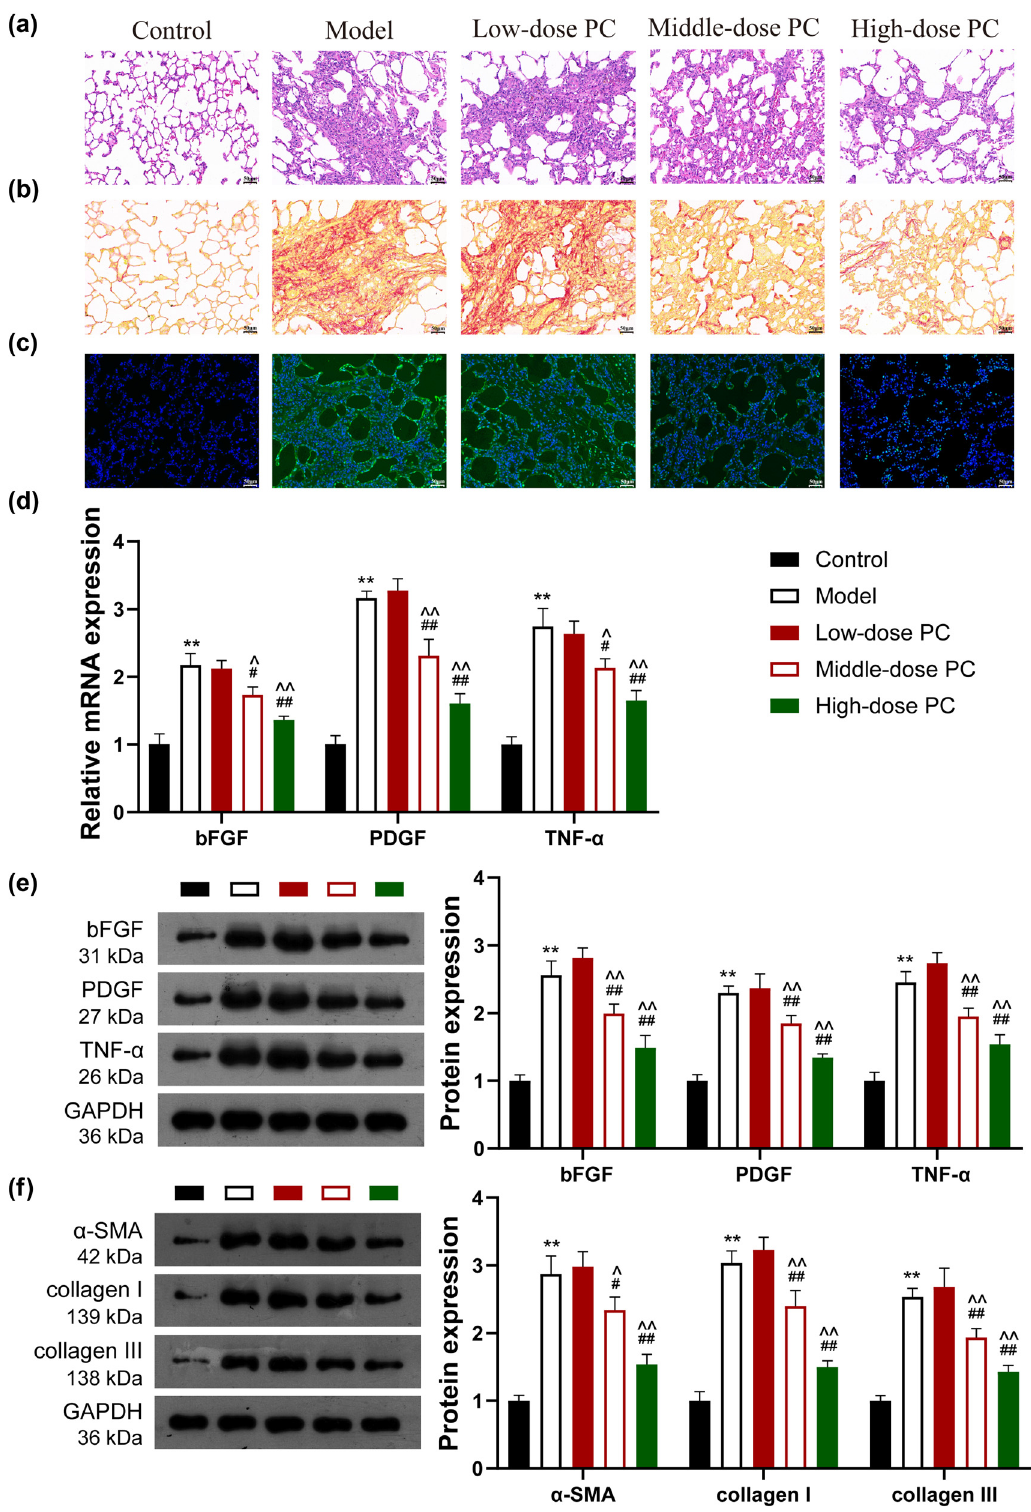
Figure 1: PC attenuates fi brosis in silicosis rats. ( a ) HE staining of lung tissues from silicosis rat model ( scale bar = 50 μ m ) . ( b ) Sirius Red staining of lung tissues from silicosis rat model ( scale bar = 50 μ m ) . ( c ) TUNEL staining of the lung tissues from silicosis rat model ( scale bar = 50 μ m ) . ( d and e ) The expression of b - FGF, PDGF, and tumor necrosis factor α ( TNF - α ) in lung tissues of silicosis rats was analyzed by RT - qPCR and western blot assays. ( f ) The expression of α - SMA, collagen I, and collagen III was detected by western blot. The silicosis rat model was established by injecting silicon dioxide suspension through tracheal intubation. After 40 - day drug treatment, the mice were sacri fi ced and the lung tissues were collected. ** P < 0.01 vs control, # P < 0.05 and ## P < 0.01 vs model, ^ P < 0.05 and ^^ P < 0.01 vs low - dose